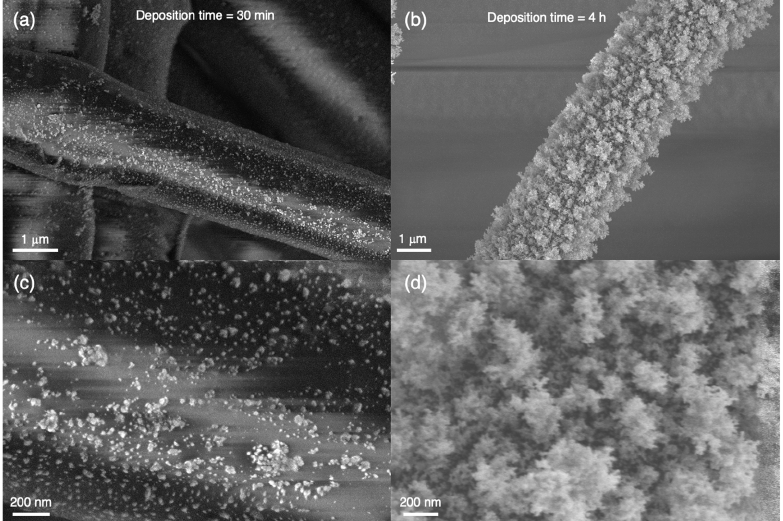
Figure 5 . SEM images of Ag nanoparticle deposits in the filter section . ( a ) Image of nanoparticles on a single fibre in the filter after a deposition time of 30 min with a power of 5 W and a flow rate of 8 lpm. ( b ) Image of nanoparticles on a single fibre on the filter after a deposition time of 4 h. ( c , d ) Similar images at higher magnification. The coating after 30 min consists of a mixture of individual